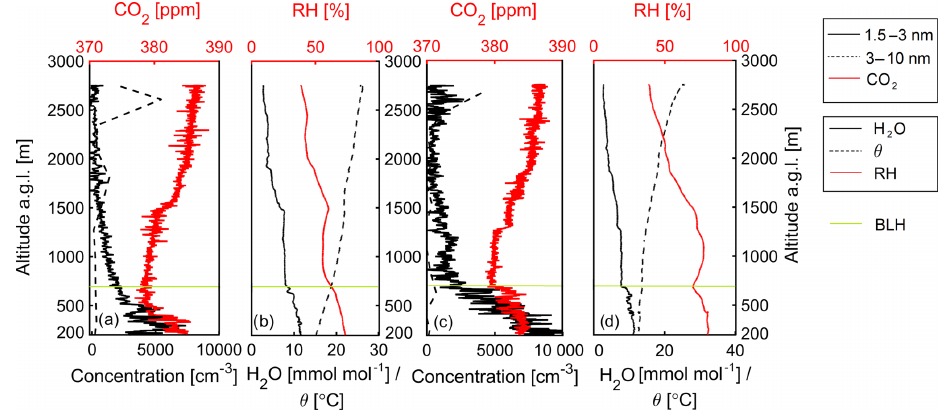
Figure 6. Vertical profiles during the first measurement flight at 07:30–09:00 on 13 August 2015 (marked in Fig. 5). Panels (a) and (b) show data from the ascent and panels (c) and (d) from the descent. Panels (a) and (c) show the number concentration of 1.5–3nm (black solid line) and 3–10nm (dashed line) particles and the carbon dioxide concentration (red). Panels (b) and (d) show water vapour concentration (black), relative humidity (red) and potential temperature (dashes line) profiles. The green line is the estimated boundary layer